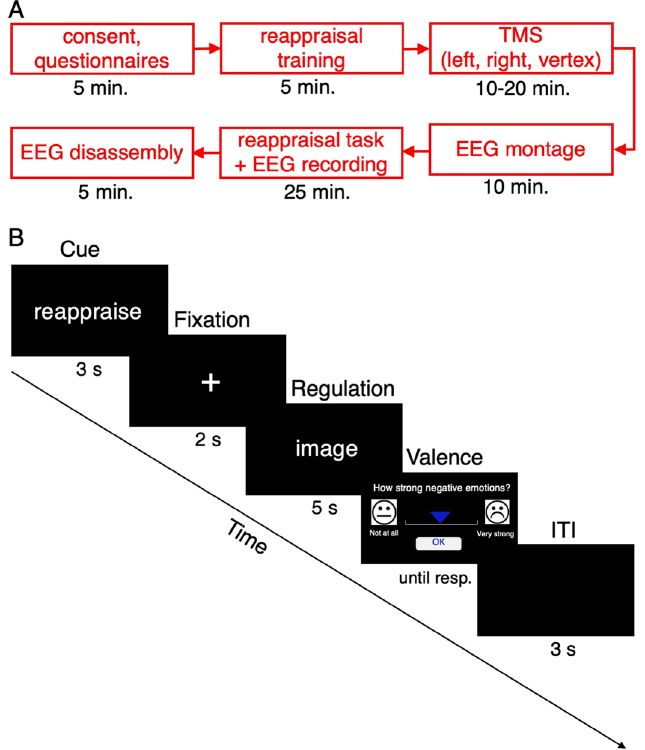
Figure 4. The experimental procedure. ( A ) Overview of a single experimental session. ( B ) Sample trial sequence. ITI inter-trial